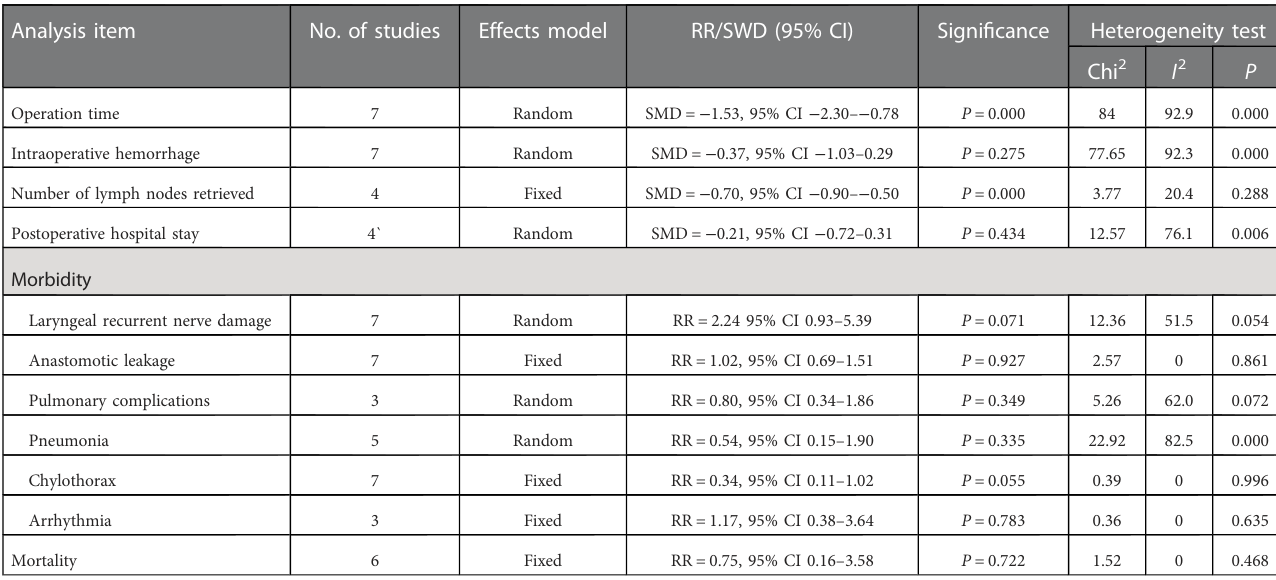
TABLE 3 Meta-analysis of perioperative